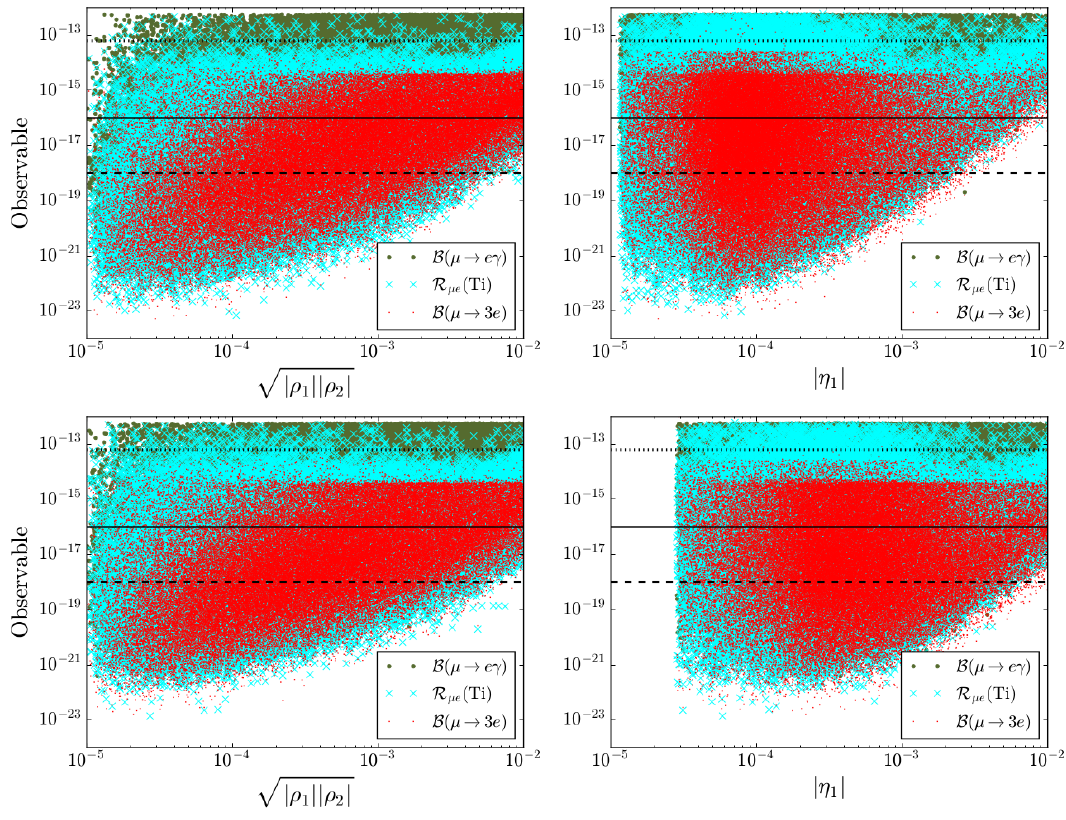
p j (cid:26) 1 jj (cid:26) 2 j (left